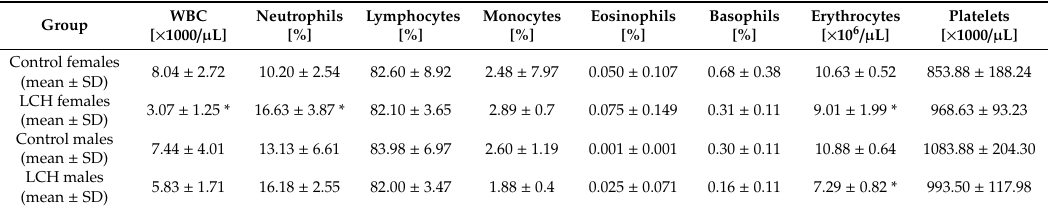
Table 3. Blood morphology in the animals.